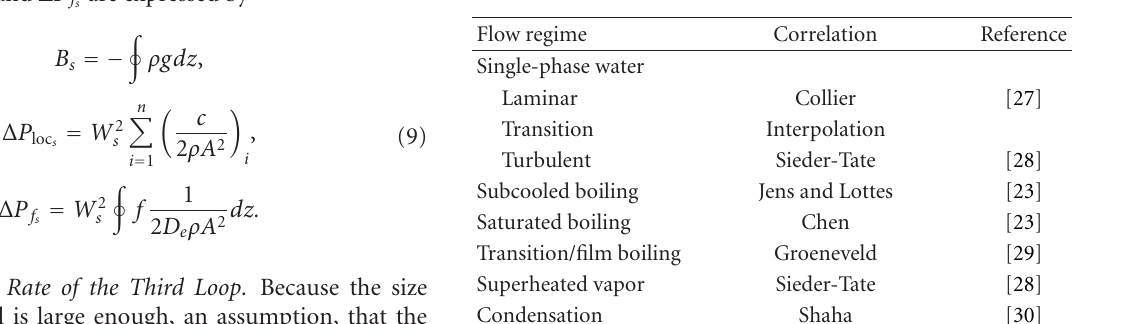
Table 1: Heat transfer